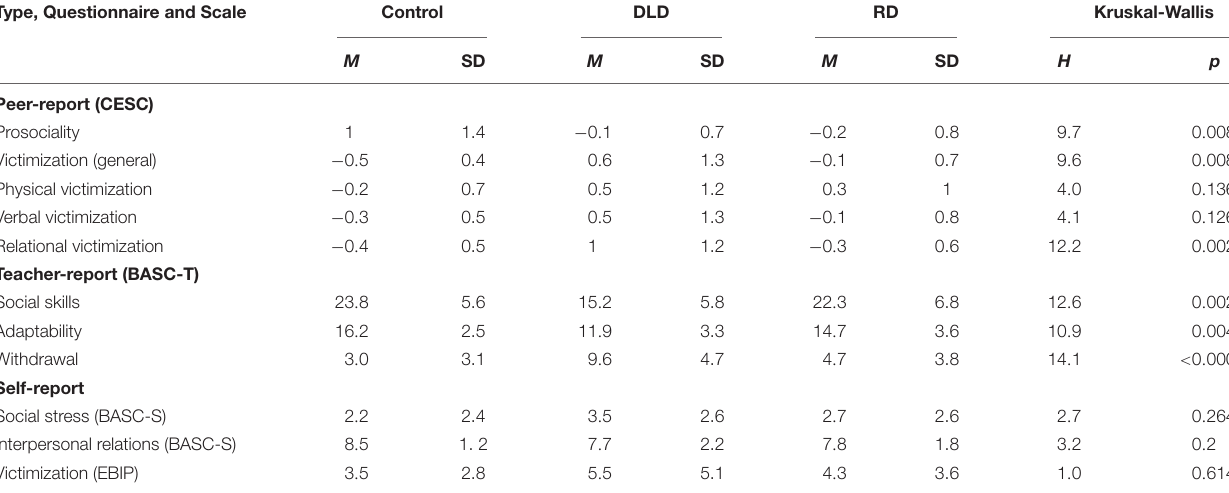
TABLE 2 | Main outcomes of the questionnaires administered by group. Type, Questionnaire and Scale